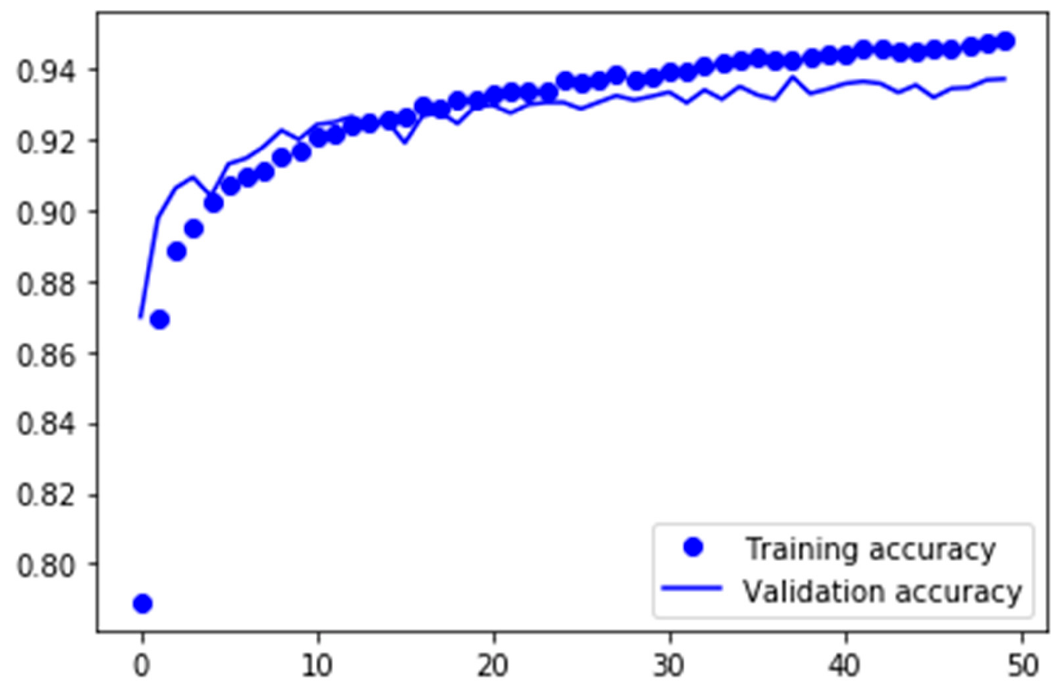
Figure 11. Training and validation accuracy of model 1.11 with dropout layers.